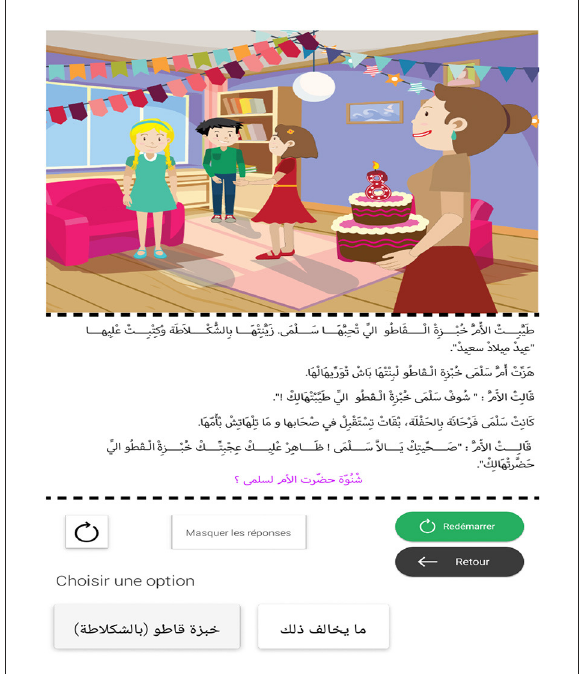
FIGURE1 Illustration of the test: “The Tunisian Social Situations Instrument”.